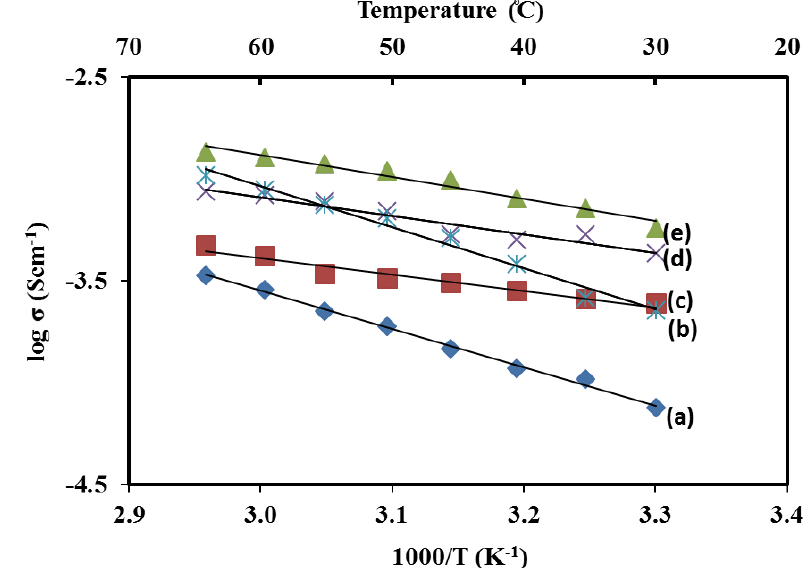
Figure 10. Temperature dependence of ionic conductivity of: ( a ) pure CMC; ( b ) 40 wt% of CH COONH ; ( c ) 10 wt% of CH 3 4 of CH COONH . 3 4